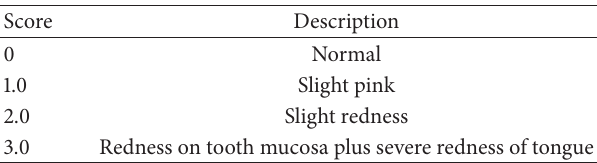
Table 2: Oral mucositis score (OMS) for methotrexate induced oral